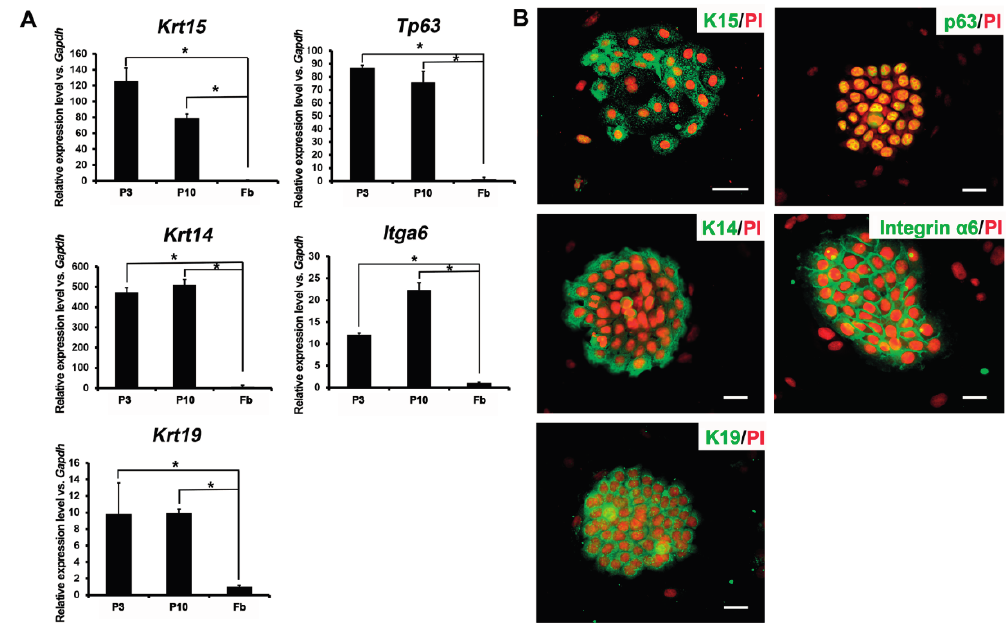
Figure 2. ( A ) qRT-PCR results showing the mRNA expression of Krt15 , Tp63 , Krt14 , Itga6 and Krt19 in the ovine bulge-derived keratinocytes at Passage 3 (P3) and P10. Ovine fibroblasts served as a negative control; ( B ) Immunofluorescence staining of K15, p63, K14, integrin α 6 and K19 in P6 ovine bulge-derived keratinocyte colonies. Note that the surrounding feeder cells are negative controls for all markers. Fb, fibroblast; scale bar, 50 μ m. PI, propidium iodide. * p <